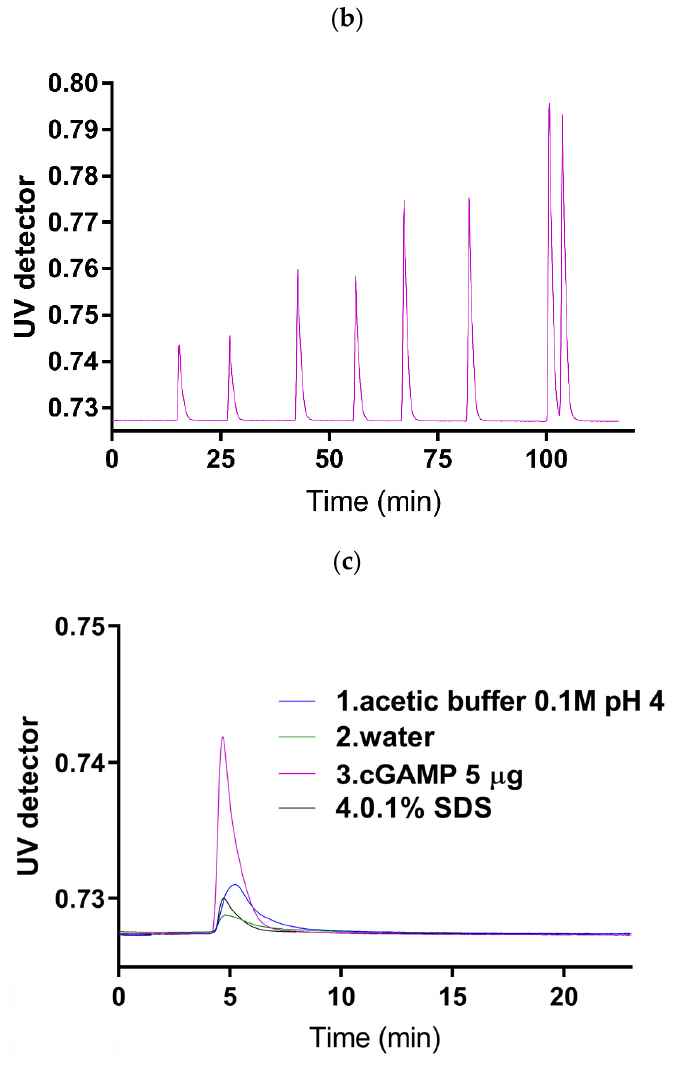
Figure 3. ( a ) AF4/UV, cGAMP calibration curve for ε determination. ( b ) Recovery comparison in between three independently injected cGAMP solutions (5 µ g) via method—cf application and no cf application. ( c ) Cleaning protocol for method: 1. Acetic buffer pH 4 0.1 M; 2. water run; 3. Sample run; 4. 0.1% SDS run. n = 3